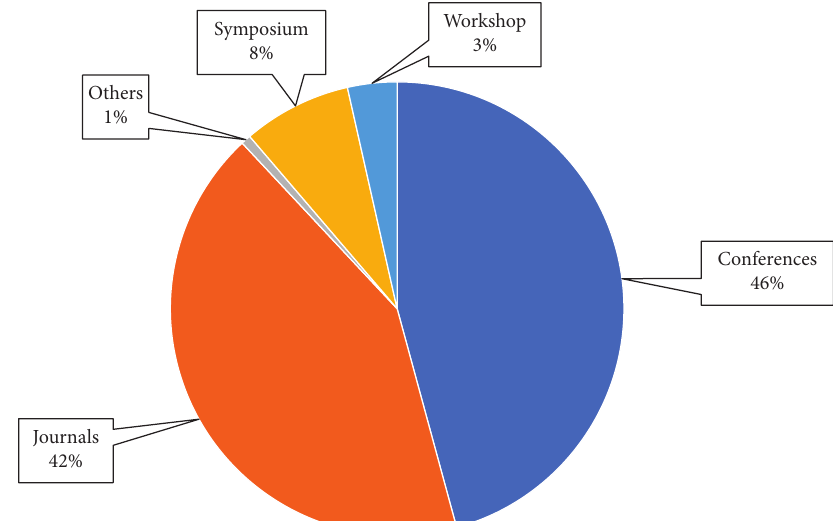
Figure 10: Publication types classification.